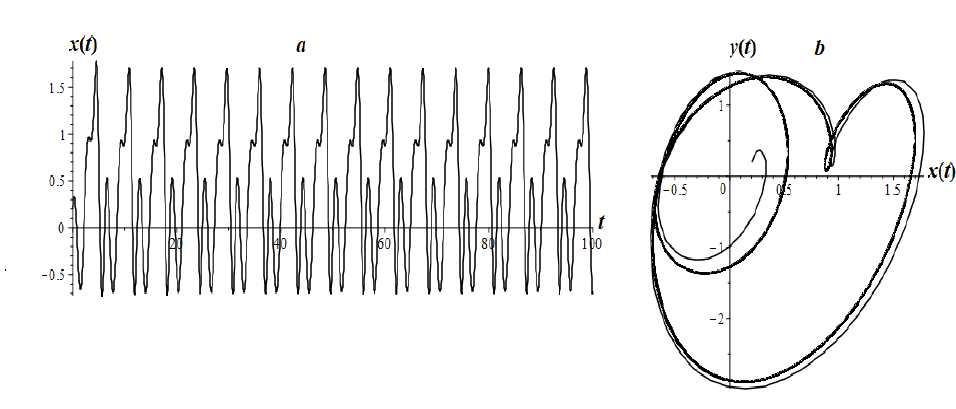
Figure 20. Multi-periodic Fractional Mathieu Oscillator Mode: ( a ) oscillogram; ( b ) phase